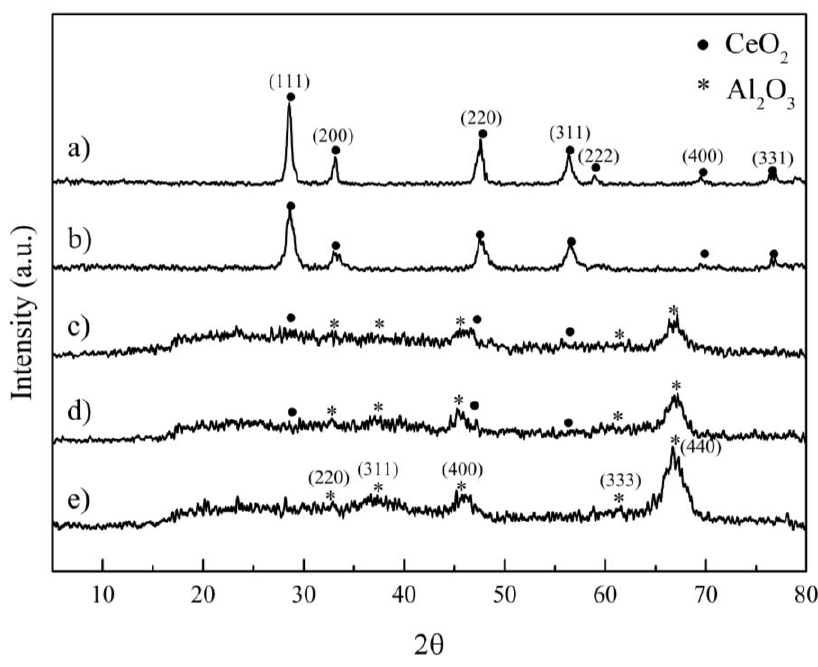
Figure 3. XRD patterns of ( a ) CeO 2 , ( b ) Ce 0.75 Zr 0.25 O 2 , ( c ) 10% CeO 2 / Al 2 O 3 , ( d ) 10% Ce 0.75 Zr 0.25 O 2 / Al 2 O 3 , and ( e ) pure alumina.